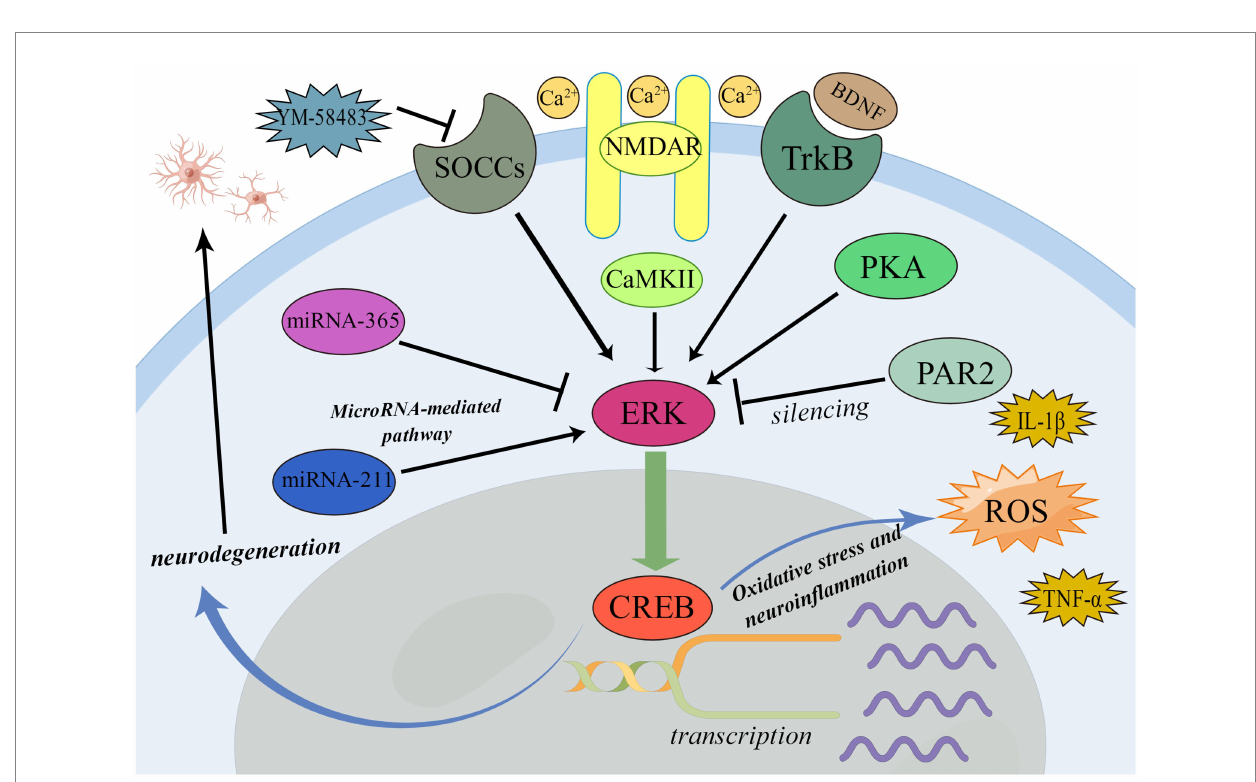
FIGURE 2 Mechanism of ERK/CREB pathway in pain and analgesia.